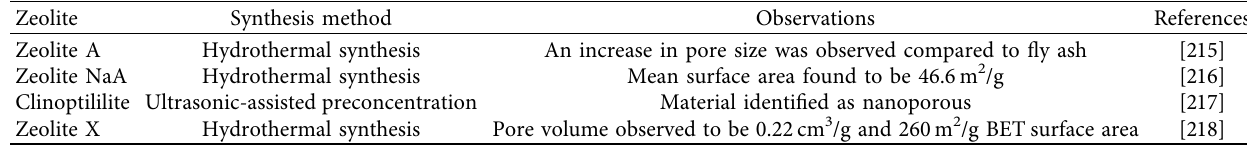
Table 5: Summary of BET analysis of zeolites.